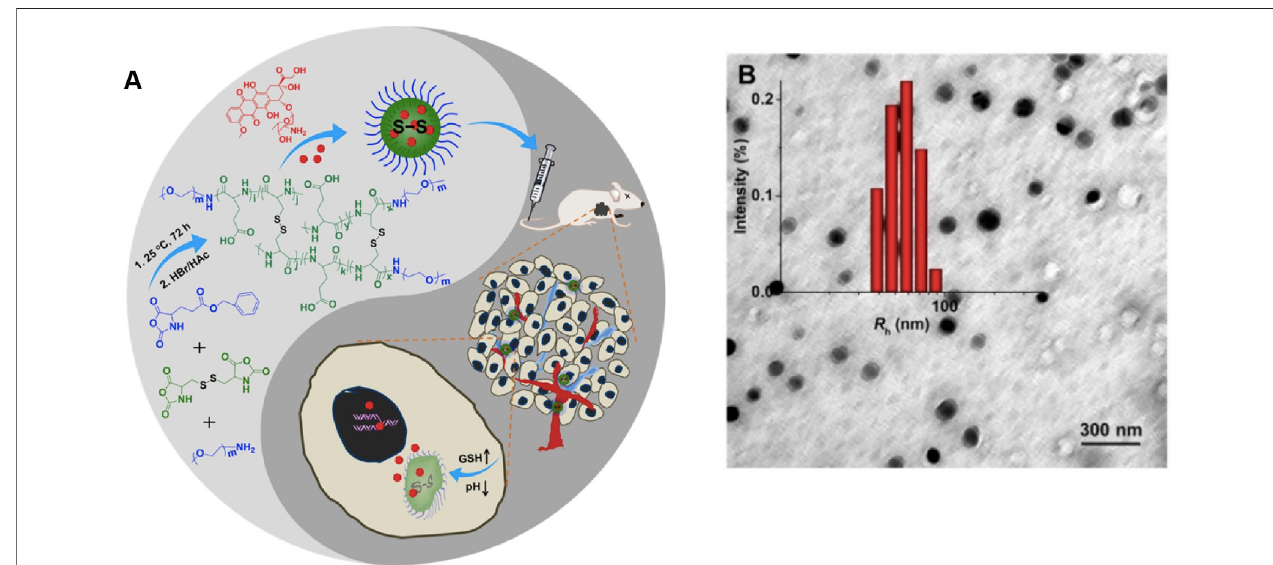
FIGURE 4 | (A) Synthetic pathway for mPEG − P (LG-co-LC) nanogel, illustration of DOX encapsulation by nanogel, and its circulation, intratumoral accumulation, endocytosis, and targeted intracellular DOX release after intravenous injection (Huang et al., 2015). (B) Typical TEM micrographs and Rh NG/DOX.